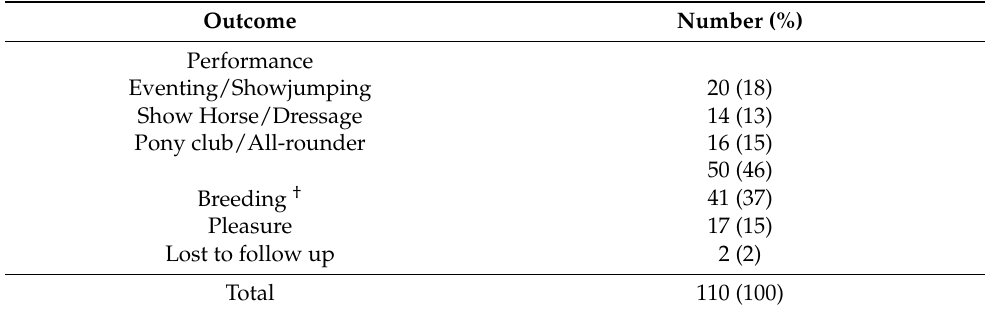
Table 6. The medium-term outcomes for 110 thoroughbred horses after retirement from racing.